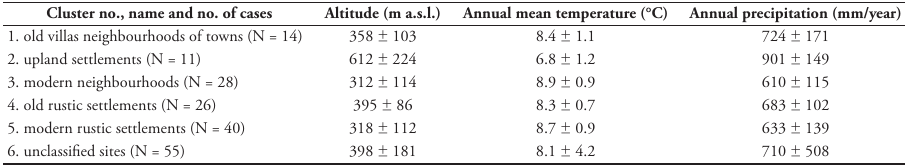
Table 2. Basic environmental variables (mean ± SD) characterising each cluster type. The data were obtained from the Czech Hydrometeorological Institute. Cluster no., name and no. of